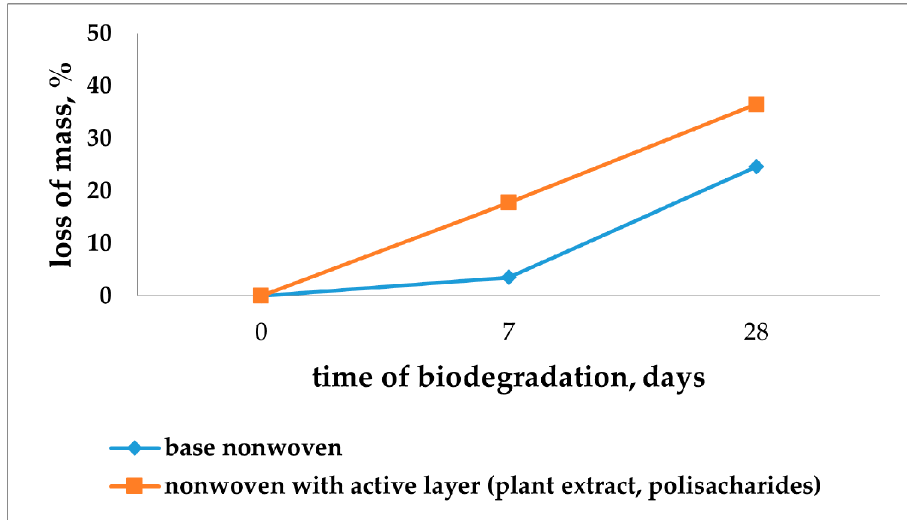
Figure 5. Biodegradation in a compost biodegradable spun-bonded nonwoven with active